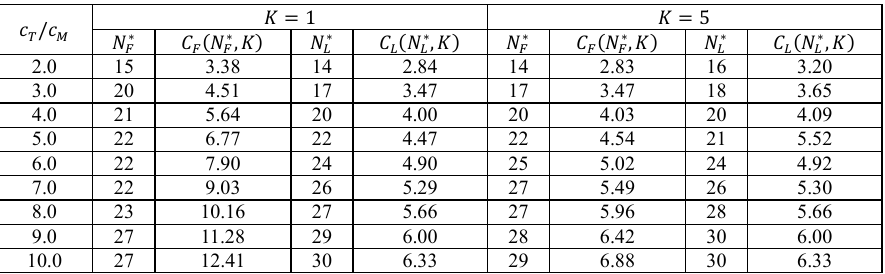
Table 7. Optimum 𝑁 𝐹∗ and 𝑁 𝐿∗ and their cost rates for given T when 𝐻(𝑡) = 𝑡 2.0 and 𝑇 =